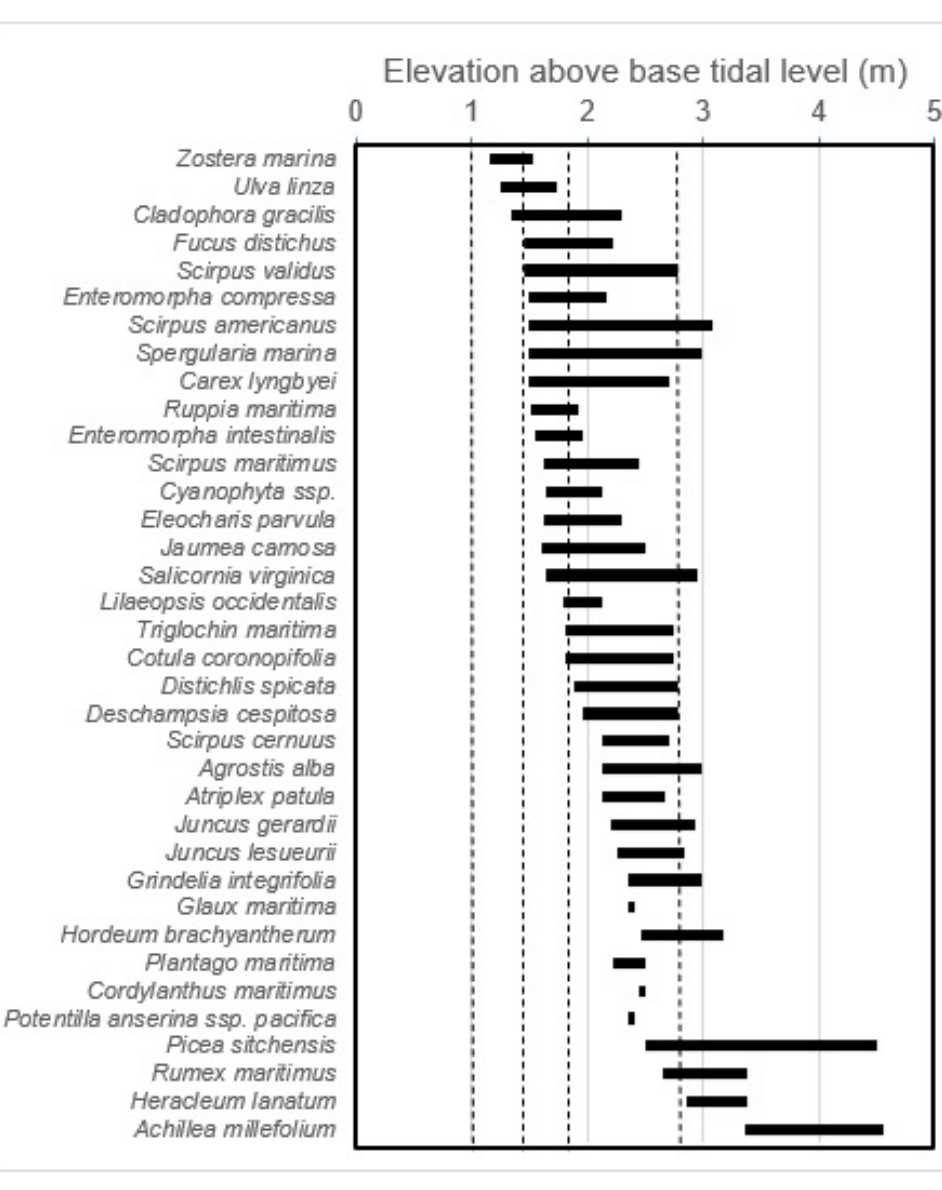
Data availability.